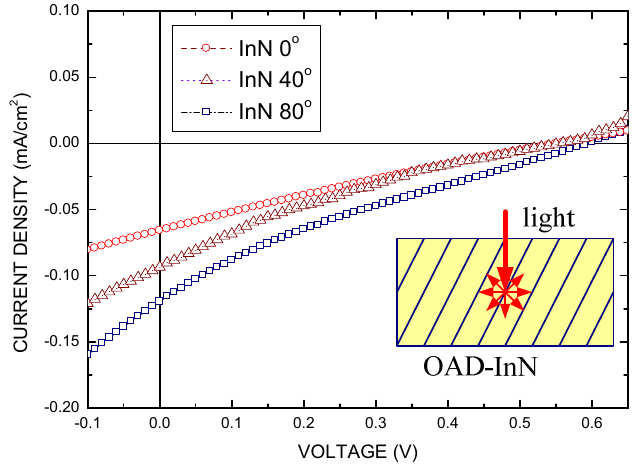
Figure 7. The J-V characteristics of the solar cells with OAD-InN sputtered at various oblique angles. The inset shows the light incident into the OAD-InN